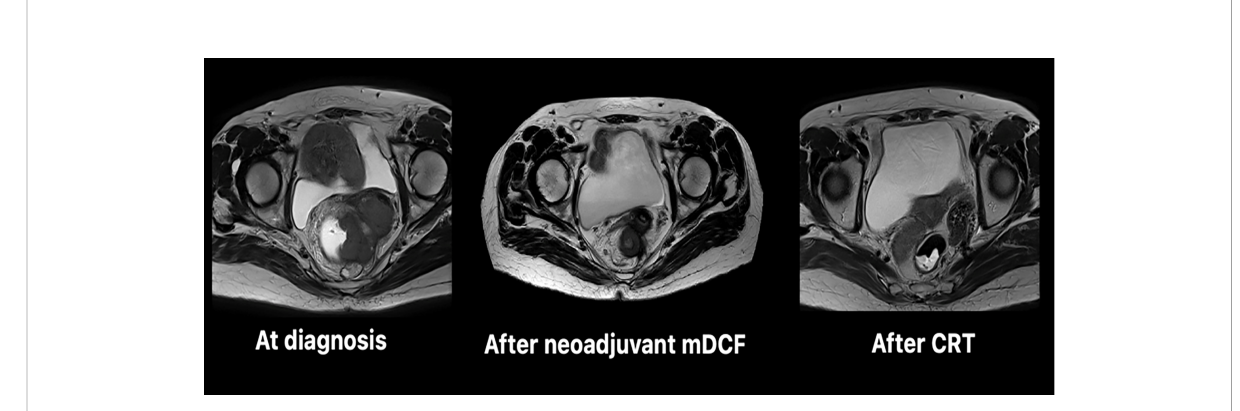
FIGURE 1 Evolution of the rectal squamous cell carcinoma followed by pelvic MRI during treatment (patient #1). CRT, chemoradiotherapy; mDCF, modi fi ed DCF